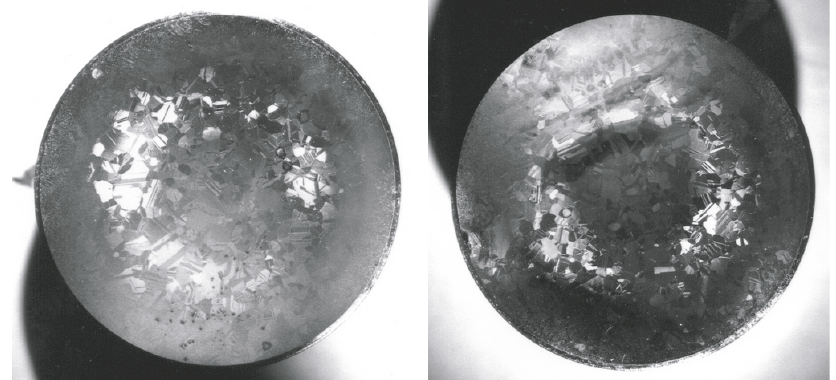
FIG. 25. Surfaces of end caps 1 (left panel) and 2 (right panel) after the second high-power test. The position of the high-power coupling aperture relative to the pictures is the top of end cap 1 and top left of end cap